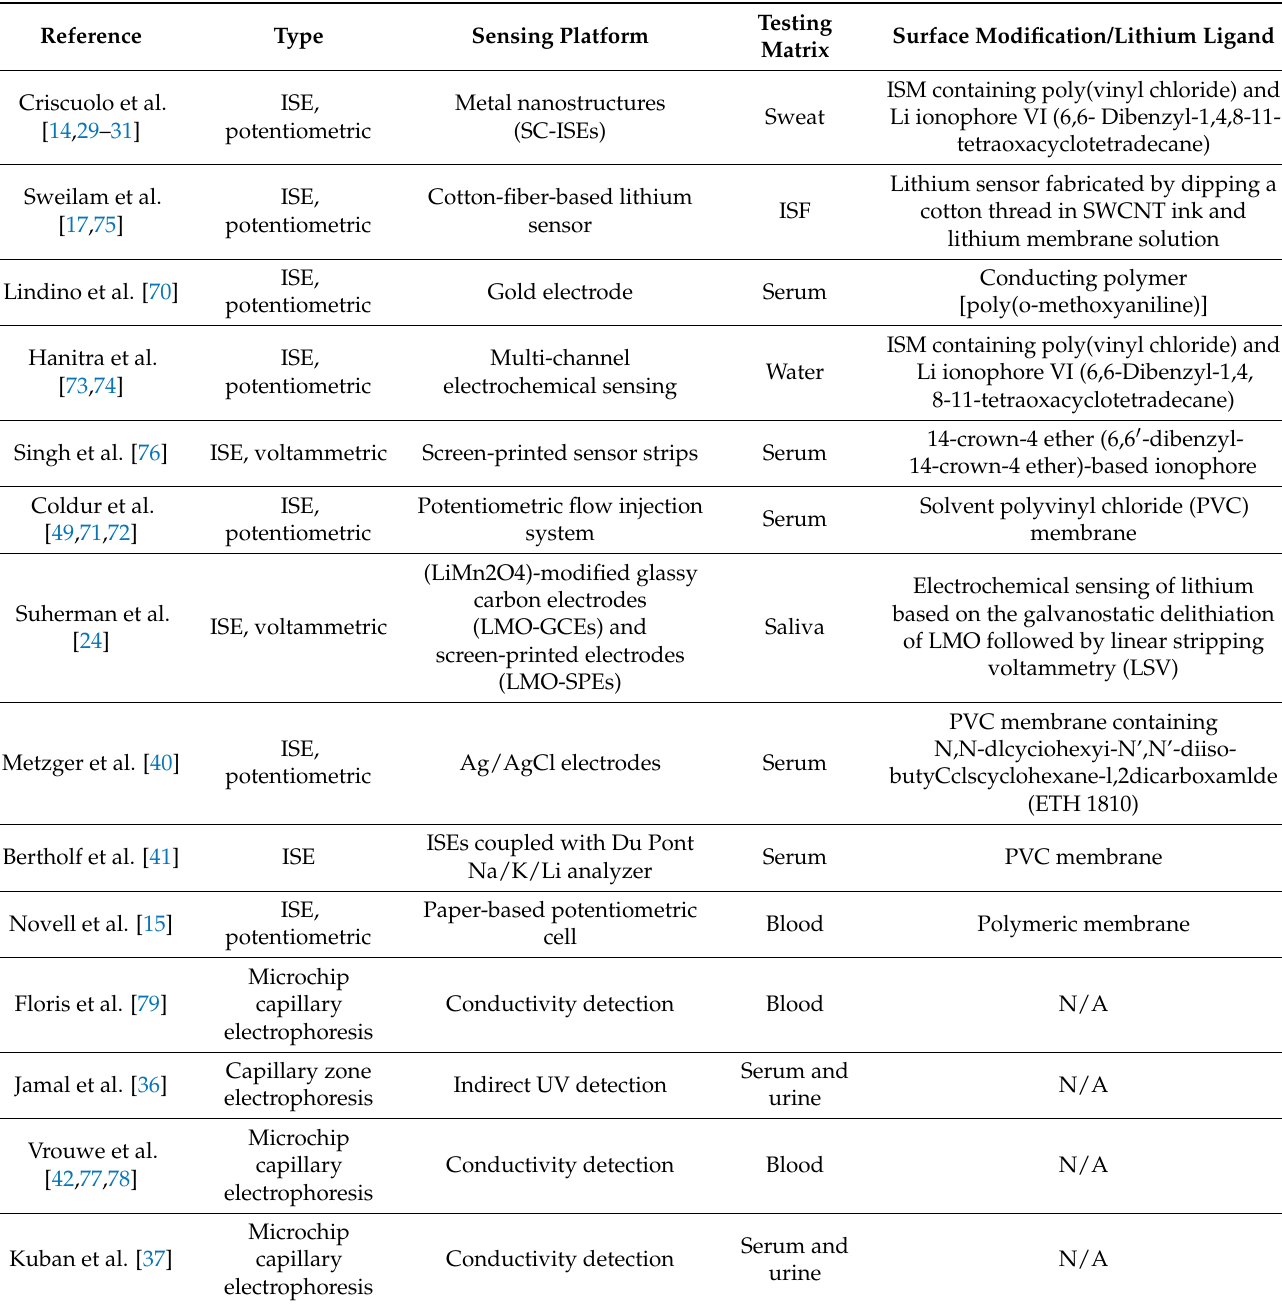
Table 3. Studies investigating electrochemical techniques for lithium therapeutic